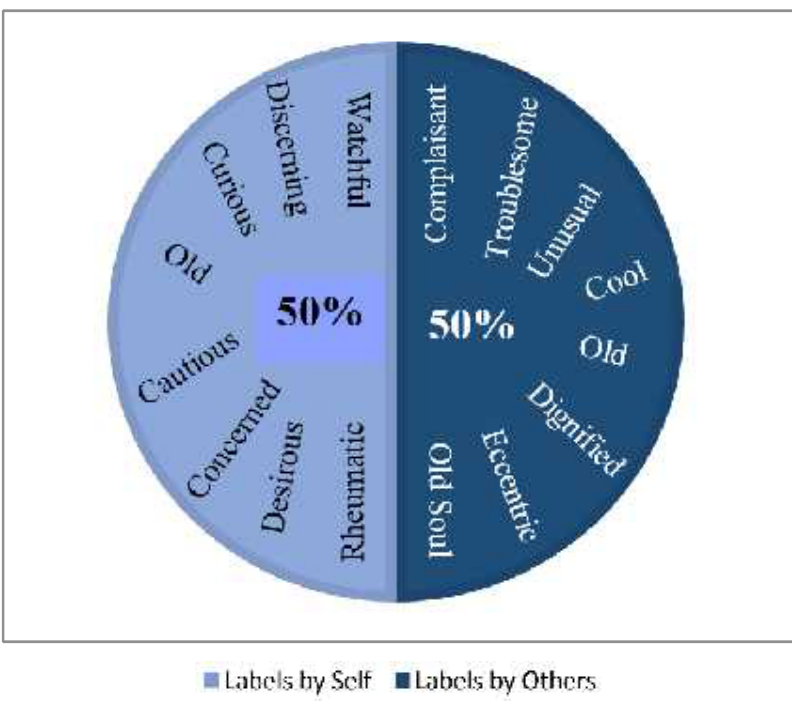
Figure 1: Dr. Heidegger’s Labels